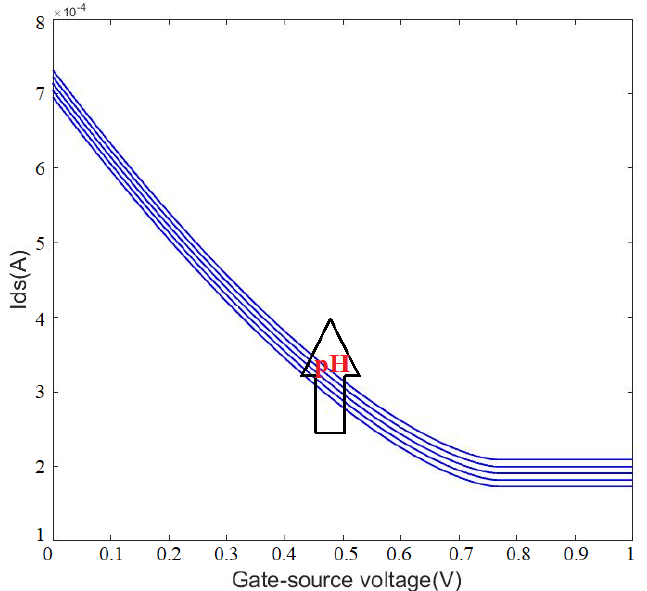
Figure 15. Mathematical modeling result of surface charge effects on the OG-JFET sensing area. The increment in pH results in more negative surface charge.